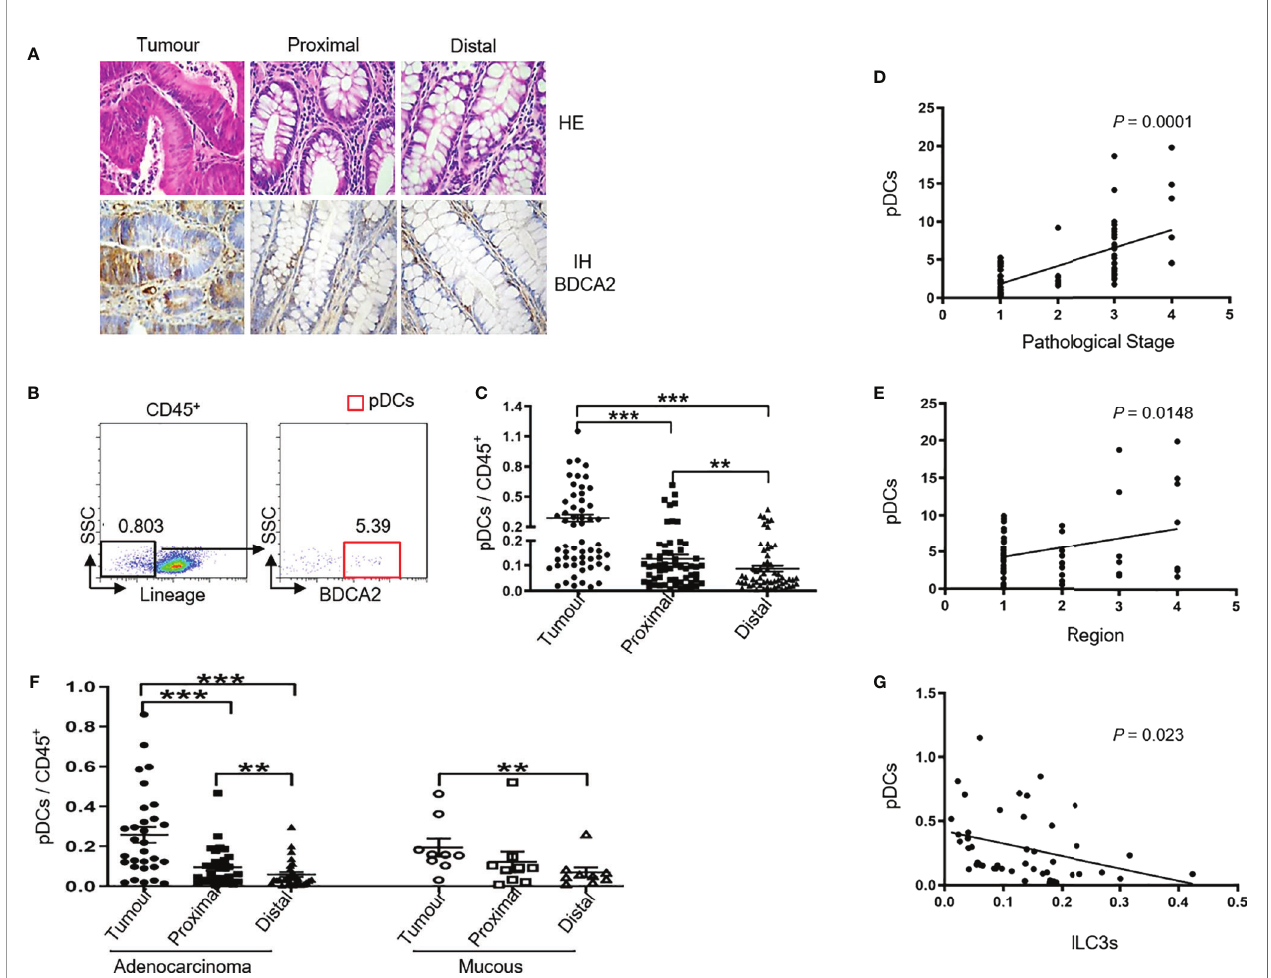
FIGURE 2 | Tumor ILC3s are negatively correlated with tumor pDC levels. MNCs from tumor, proximal, and distal regions of 58 patients with colon cancer were prepared. (A) Representative H&E and immunohistochemistry staining of BDCA2 in tumor, proximal, and distal tissues from patients are shown (magni fi cation, 400×). (B) The gating used to de fi ne pDCs: MNCs were stained for Lin, CD94, CD34, CD1a, TCR a / b , TCR g / d , CD45, BDCA2, and pDCs were identi fi ed as Lin − CD94 − CD34 − CD1a − TCR a / b − TCR g / d − CD45 + BDCA2 + . (C) pDC levels among CD45 + cells in the indicated tissues. (D) Correlation between the percentage of pDCs in tumor (T) versus distal (D) tissue specimens and the pathological stage of colon cancer. (E) Correlation between the percentage of pDCs in tumor (T) versus distal (D) tissue specimens and the region of the tumor in the colon: 1, 2, 3, and 4 represent ascending, transverse, descending, and sigmoid colon, respectively. (F) Percentage of pDCs among CD45 + cells in colon glandular cancer and mucous carcinoma tissues. (G) Correlation between the number of ILC3s and pDCs among tumor in fi ltrating CD45 + cells. In (B , D , E , G) , each dot represents one patient. In (C , F) , each symbol (circle, tumor; square, proximal region; triangle, distal region) represents the indicated tissue specimen from one patient. A paired t -test and Spearman test were used for statistical comparisons. * P < 0.05; ** P < 0.01; *** P <